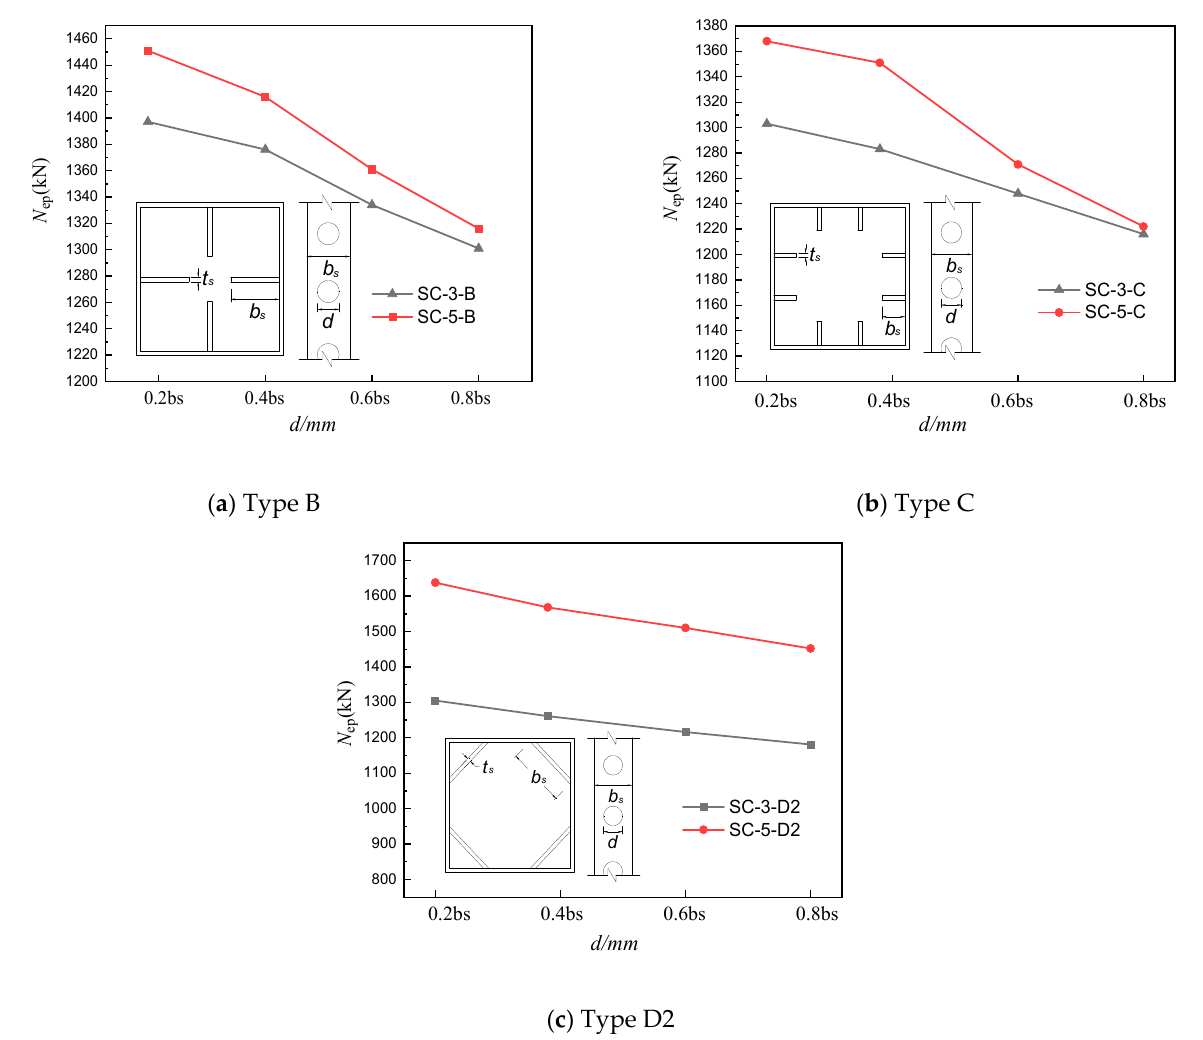
Figure 19. Effect of opening diameter 𝑑 on ultimate strength.